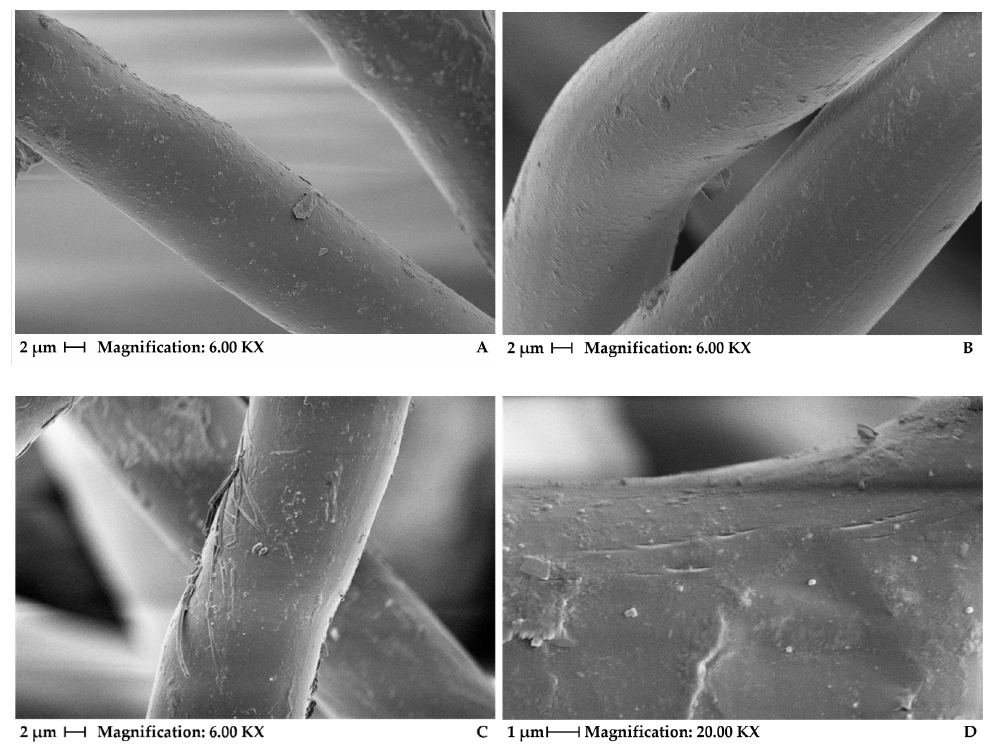
Figure 2. Scanning electronic microscopy: ( A ) virgin PET, ( B ) PET 500 h, ( C and D ) PET 1000